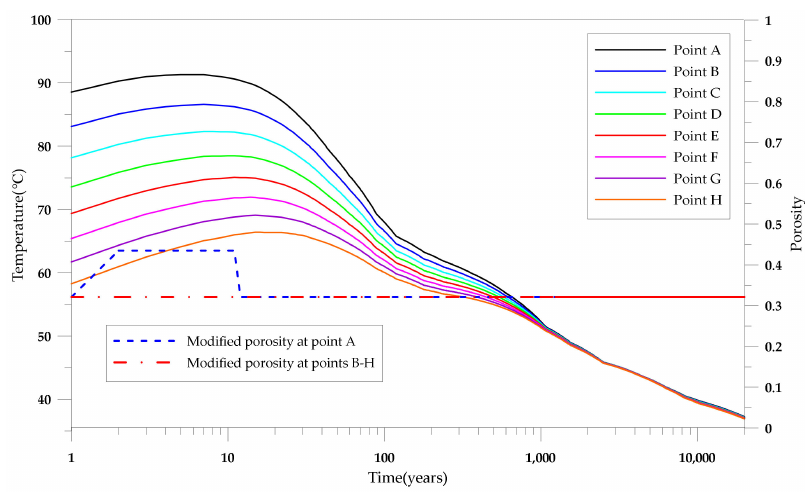
Figure 12. Temperature and modified porosity distribution at points A–H.